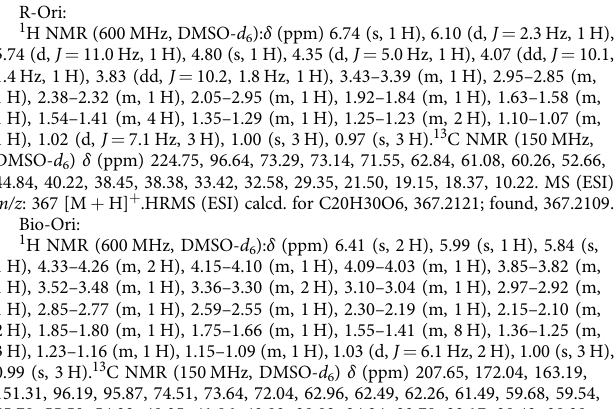
Human samples . The adult peripheral blood samples were obtained from four healthy donors at Hefei Blood Bank and the experimental protocols were per- formed according to the approved guidelines established by the Institutional